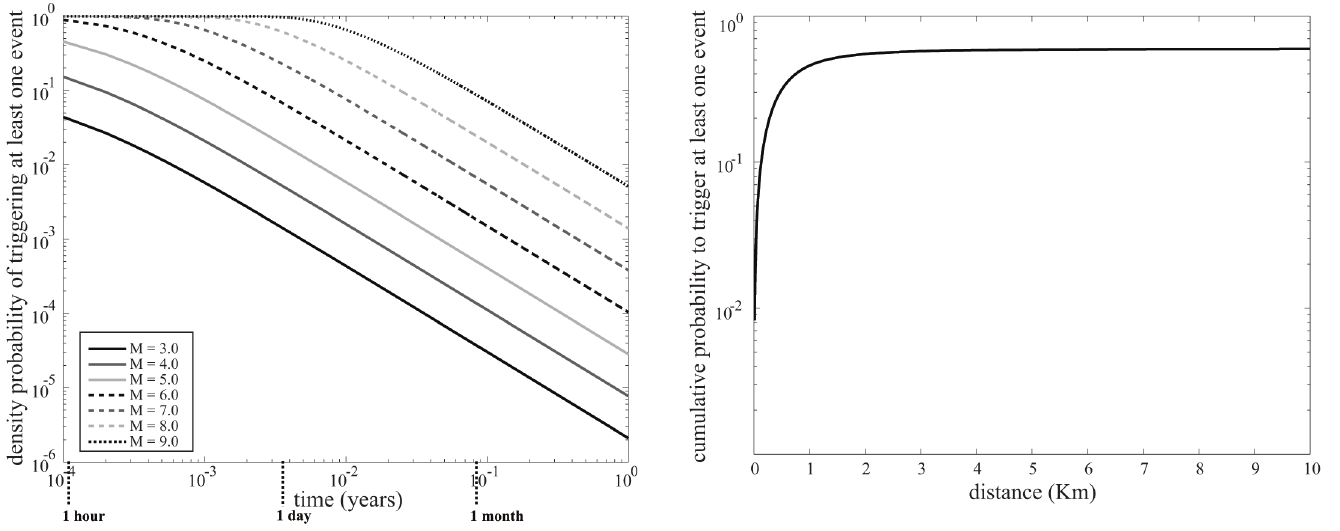
Figure 4. Spatio-temporal behavior of the triggering probability inferred by the ETAS model. a) Time decay (according to the Omori law) of the probability of generating at least one event for different magnitudes. b) Cumulative spatial probability distribution of triggering at least one event (see Equation